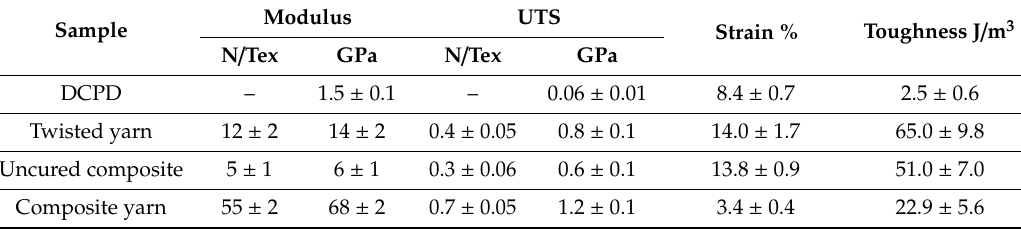
Figure 7. Stress–strain responses for twisted CNT yarn, cured composite yarn, uncured composite yarn and DCPD polymer. Table 1. Mechanical properties of DCPD polymer, twisted yarn, uncured composite and cured composite yarn.